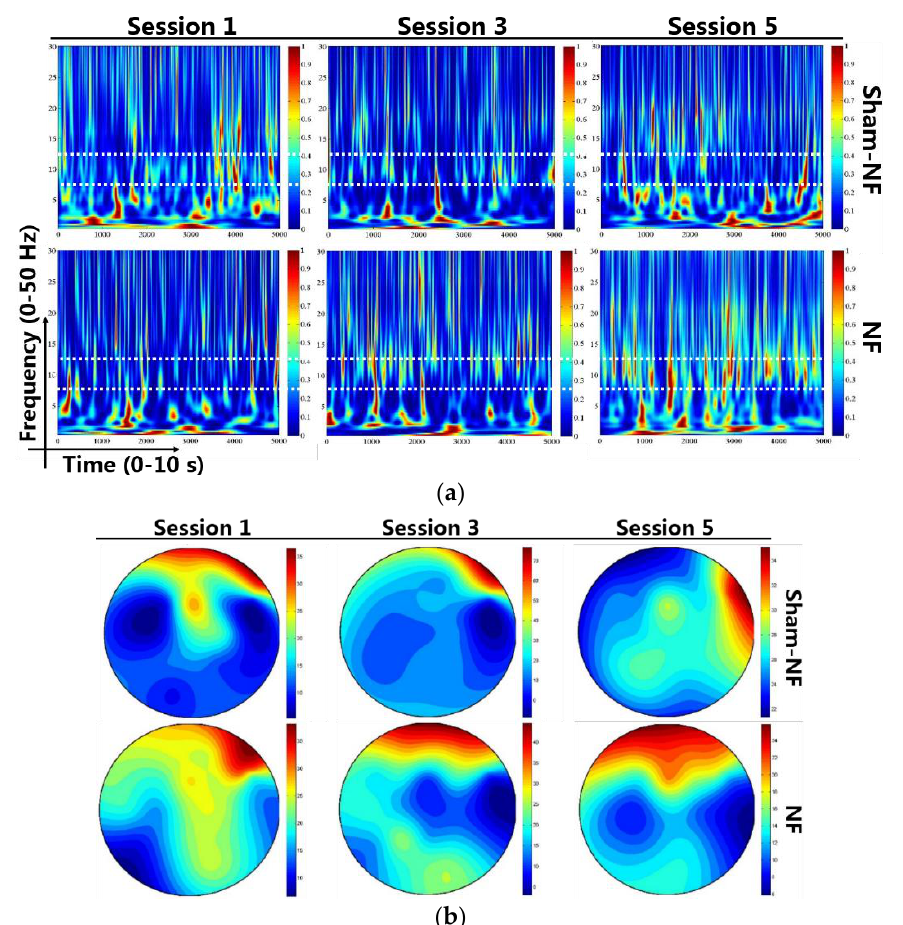
Figure 3. Time-frequency plots of EEG and averaged whole head EEG mapping of alpha frequency in the 1st, 3rd, and 5th sessions of a subject in the NF Group and Sham-NF group. ( a ) Time-frequency plots: The horizontal axis shows the time range, and the vertical axis shows the frequency range. The box with the dotted white line shows the induced power of the alpha (8–12 Hz) frequency band; ( b ) The distribution of the energy of alpha power in different sessions of a subject in the NF group and sham-NF group.